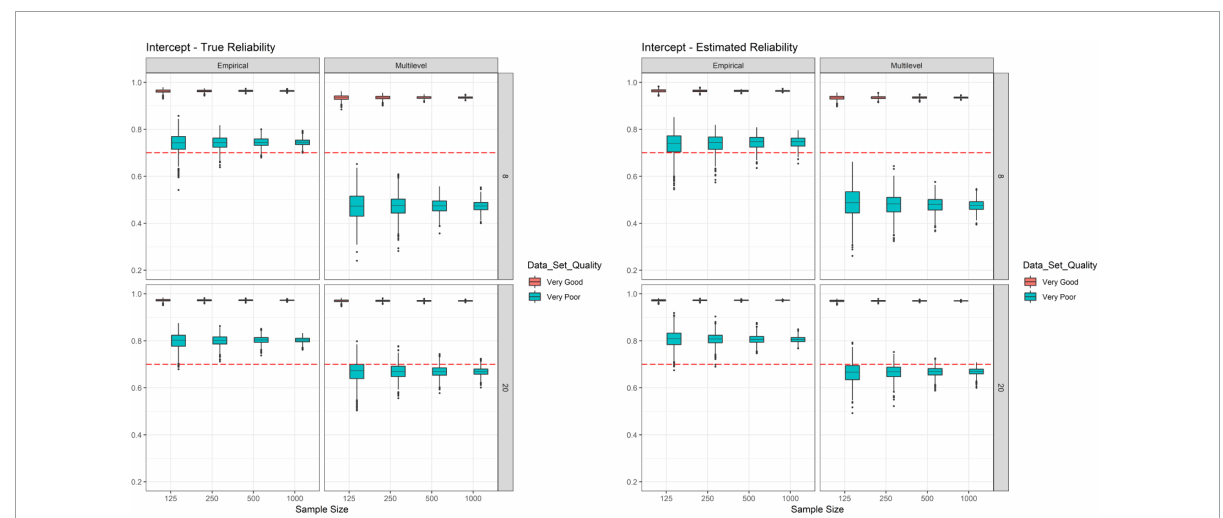
FIGURE1 Simulation study–true reliability and estimated reliability of intercepts. Each box represents one cell of the simulation design and is based on 1,000